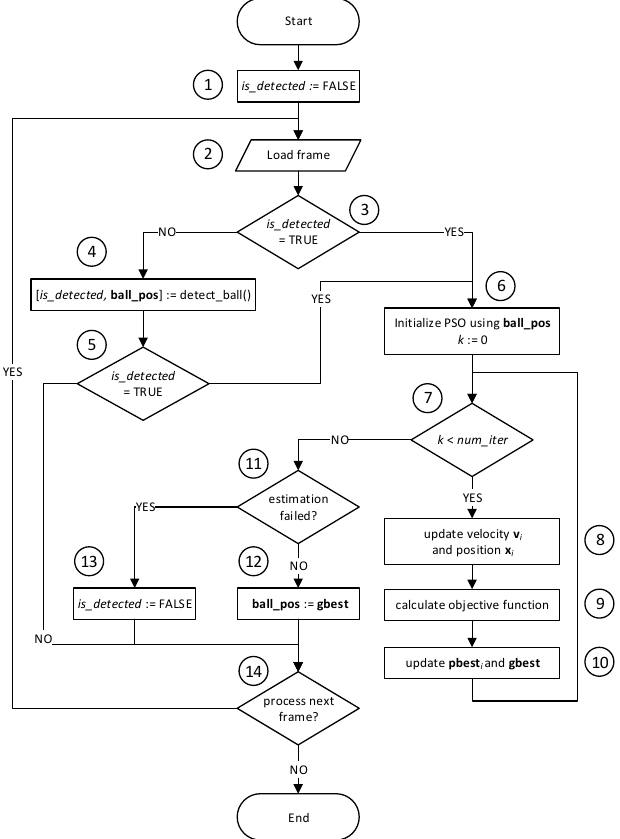
Figure 2. Block diagram of the ball detection and tracking